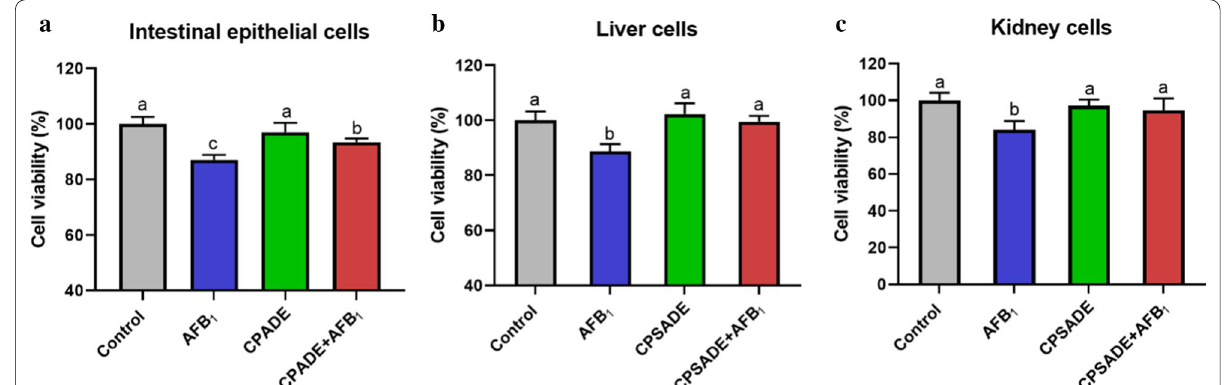
Fig. 3 Effects of CPADE or CPSADE on alleviating viabilities of primary intestinal epithelium ( a ), liver ( b ) and kidney ( c ) cells induced by AFB 1 after 12 h reaction (n 8). The different letters on each bar indicate significant difference from each other ( p < 0.05), while the same letters on each = bar indicate insignificant difference from each other ( p > 0.05). Control: DMEM/F12 or M199; AFB 1 : 200 μg/L for primary intestinal epithelium cells, 40 μg/L for liver and kidney cells; CPADE: compound probiotics AFB 1 ‑degradation enzyme; CPSADE: cell‑free compound probiotics + supernatant AFB 1 ‑degradation +